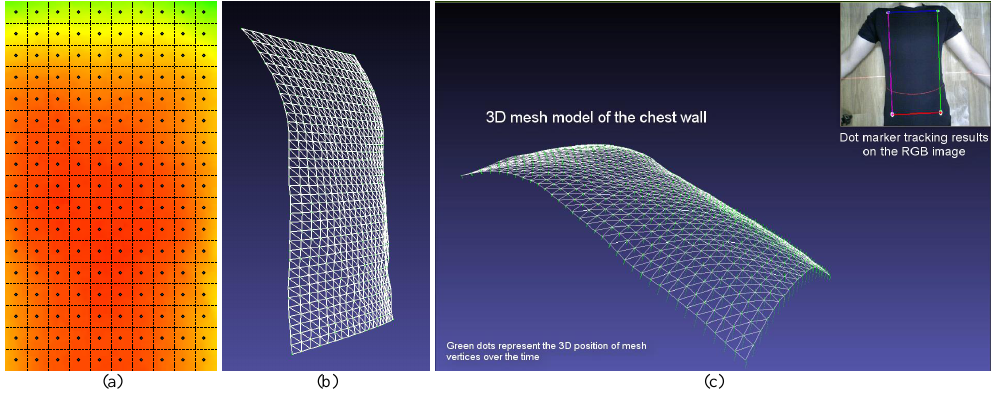
Figure 9. The surface mesh generation process. ( a ) The rectangular ROI of the reconstructed depth is further divided into smaller square ROIs; ( b ) a surface mesh is generated by finding the 3D coordinate of the midpoints of smaller ROIs using the average depth value of the region; ( c ) a selected frame of a video sequence, which shows the motion of the chest wall in a 3D viewer using a mesh model. Green dots represent the 3D position of mesh vertices over time.